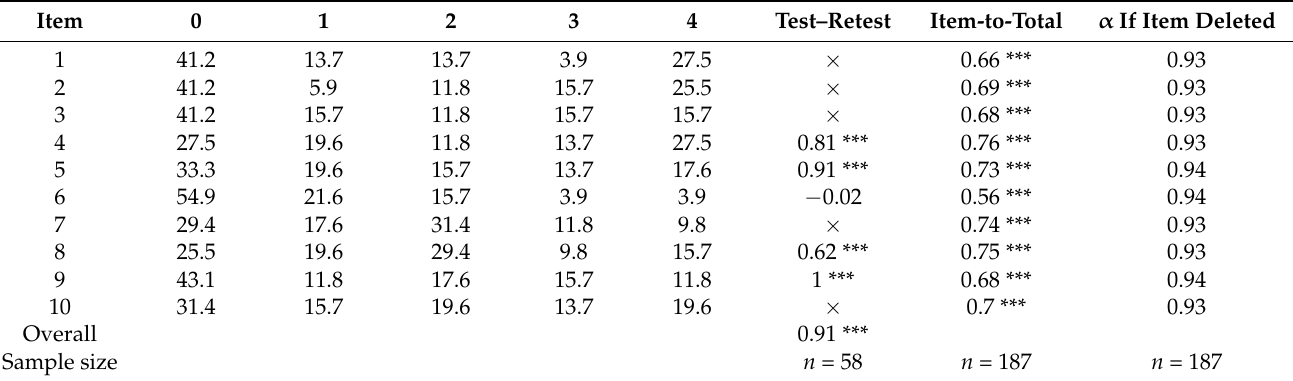
Table 3. Relative frequency (%) of answers to EAT10 ® items and reliability parameters of the Slovak version of EAT10 ®